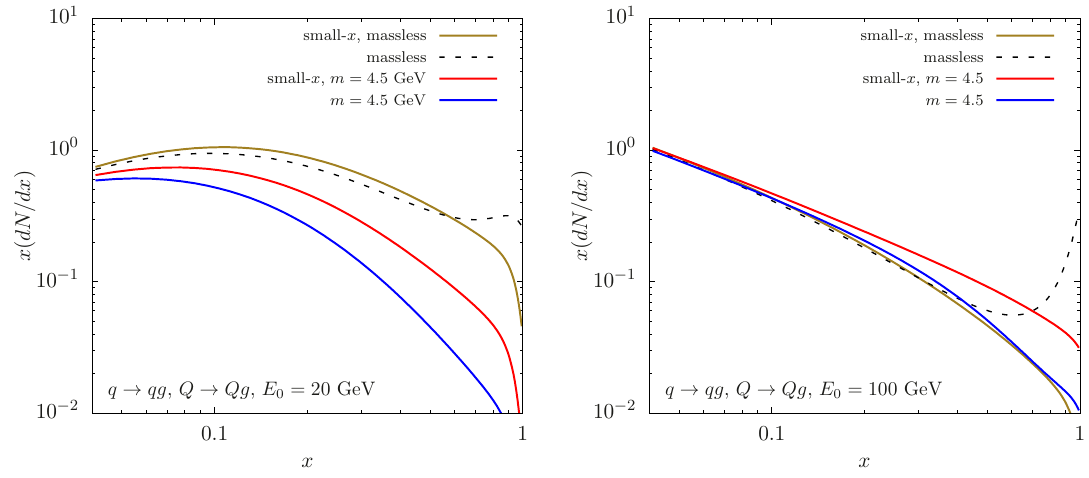
Figure 3 . Comparison of the intensity spectra x ( dN=dx ) for the quark-to-quark splitting process. The massive results for the full splitting function Q ! Qg are shown in blue, whereas the corre- sponding small- x results are shown in red. We choose the mass of the bottom quark as an example, m b = 4 : 5 GeV. For comparison, we also plot the massless results q ! qg for both the full splitting function (dashed black) and the small- x limit (green). The q numerically with a realistic model for the medium and physical phase space cuts, see text and [46]. As an example, we choose the incident parent parton energy as E 0 = p + E 0 = 100 GeV (right).